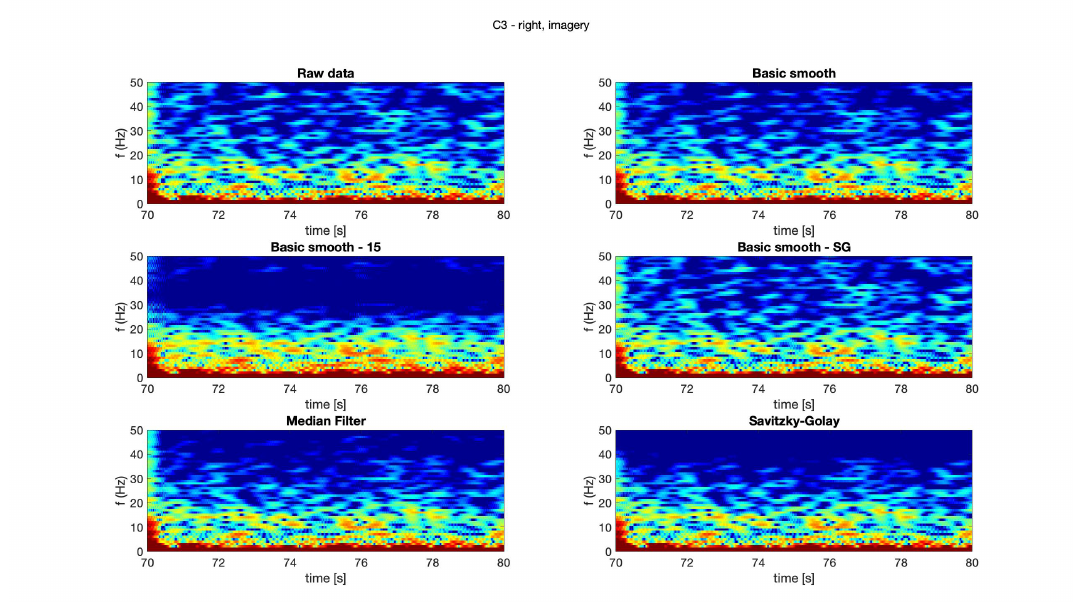
Figure 10. Spectrogram—C3, right hand, imagery